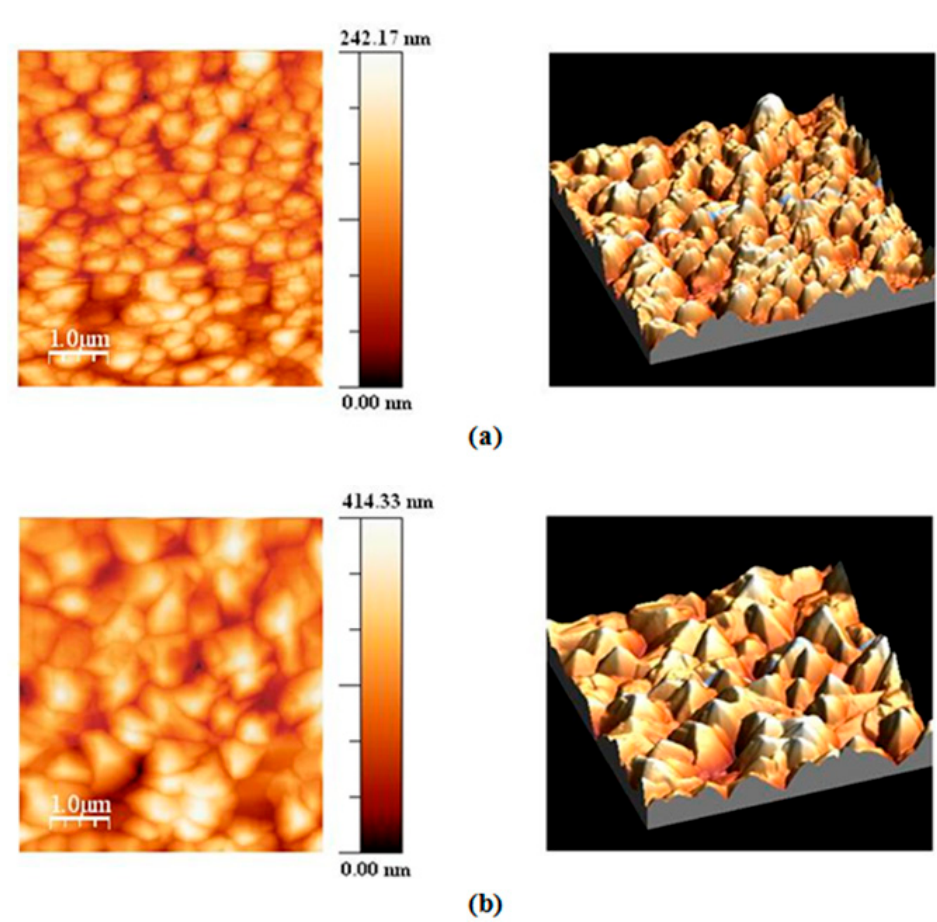
Figure 4. Two-dimensional and three-dimensional AFM images of Zn 1 − x Ni x O thin films with content of Ni: ( a ) x = 0.02; ( b ) x = 0.06.